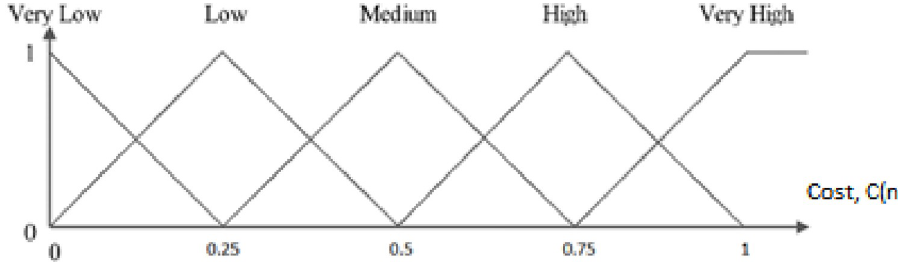
Fig 5. Fuzzy diagram of cost calculation for each node combination condition (cost